Question: Write a single sentence explaining what this figure depicts.
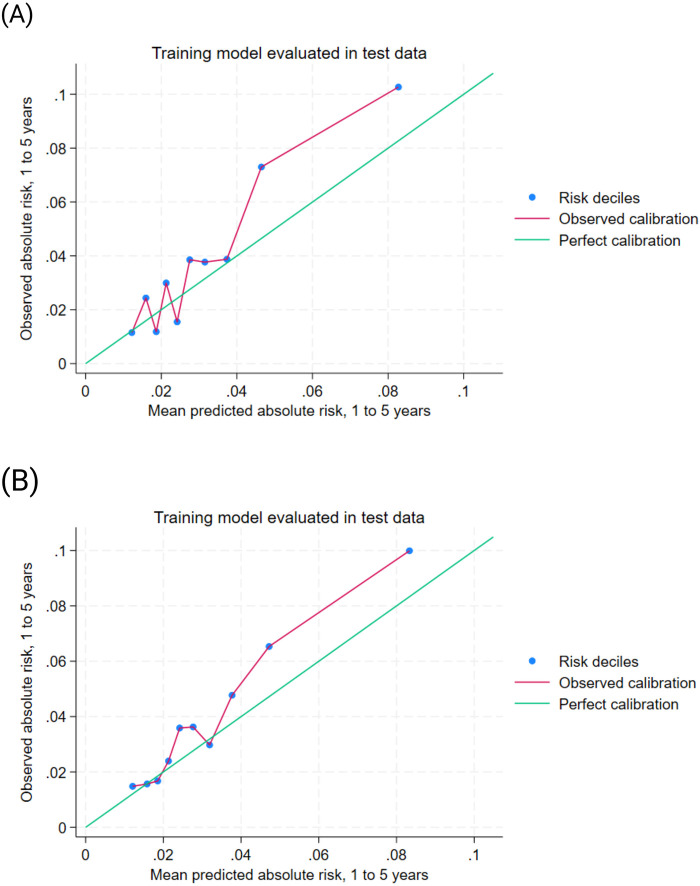
Answer: Calibration plots for the best predictive models of 1–5 year TLR risk. (A) Calibration plot for Cox regression with forward selection; (B) Calibration plot for Cox-LASSO. TLR = target-lesoin revascularization; LASSO, Least Absolute Shrinkage and Selection Operator. Created in BioRender. El-Faramawi, M. (2026) https://BioRender.com/tubl8d3 .